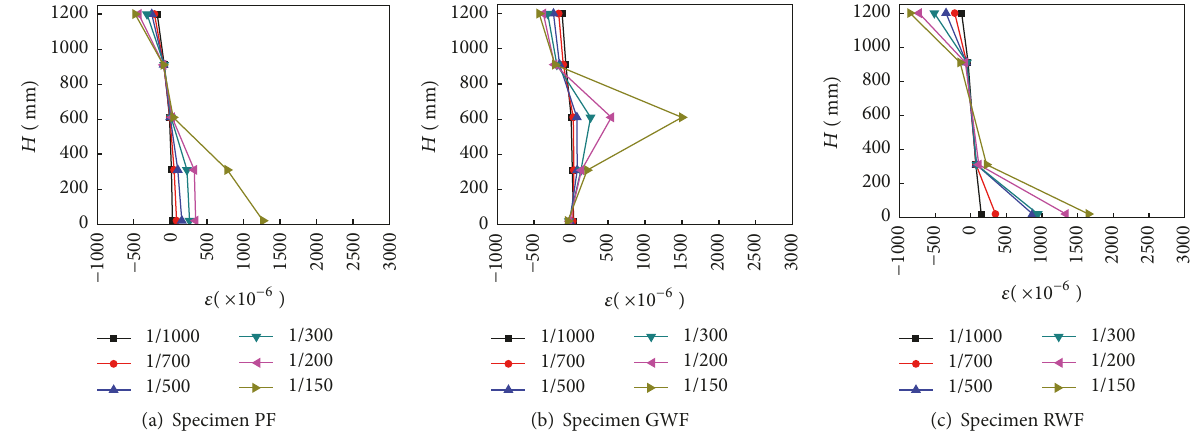
Figure 10: Strain in the longitudinal bars of the left column. Table 3: Strength parameters of the materials.